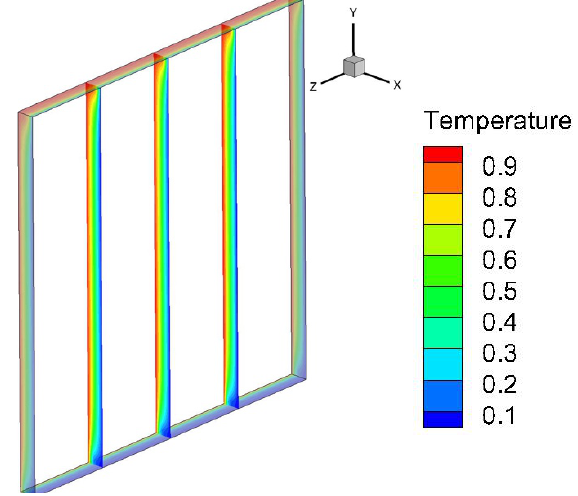
Fig. 2. Temperature fields in different sections of the computational domain for Rayleigh numbers